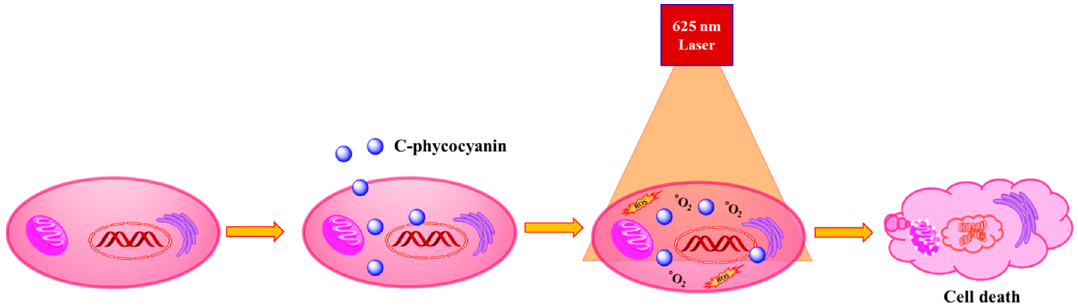
Scheme 1. Systematic representation of c-phycocyanin uptake by MBA-MD-231 cells and subsequent photodynamic therapy using a 625-nm laser. photodynamic therapy using a 625-nm laser.